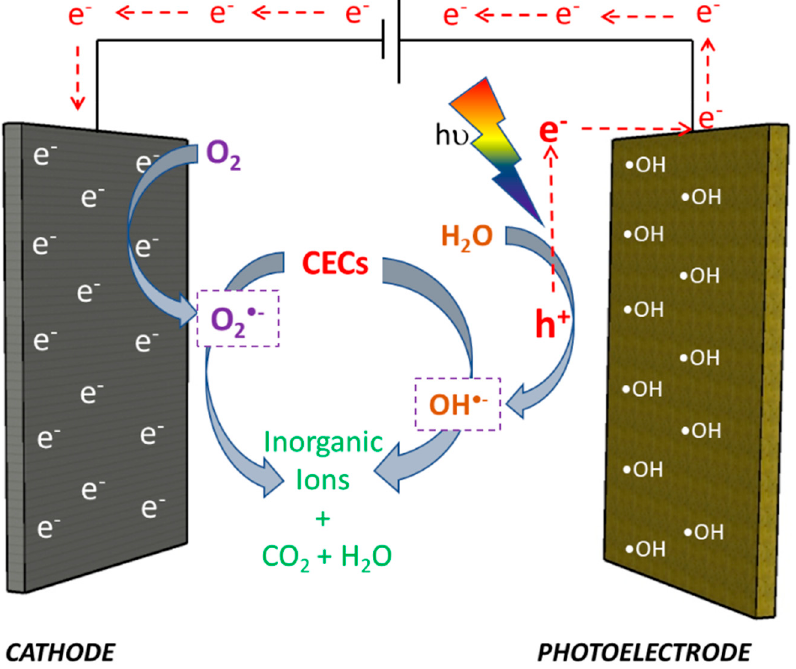
Figure 1. Schematic representation of the PEC process.